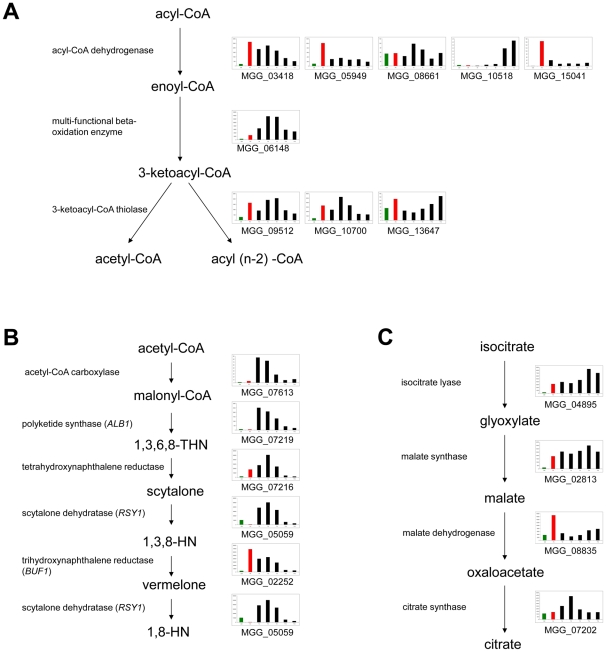
Expression of genes encoding enzymes from three metabolic pathways that affect the pool of acetyl-CoA.
A. The β-oxidation pathway, B. melanin biosynthesis, C. the glyoxylate shunt. For each enzyme, bar graphs show abundance of transcripts encoding this gene in: Guy11 mycelium grown in complete medium (green bar), Δpmk1 mutant conidia left to germinate for 4 h (red bar), Guy11 time course of appresorium development (4 h, 6 h, 8 h, 14 h, 16 h – black bars left to right).